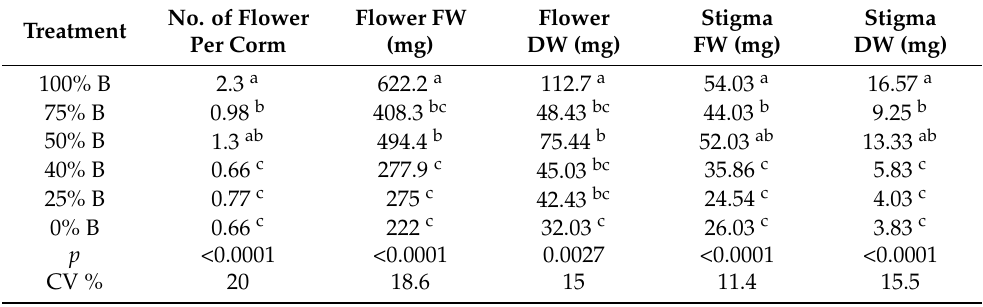
Table 2. Flower properties of saffron plants grown under different ratios of Blue (B) to Red (R) light in the overall light spectral composition, including 100% B, 75% B, 50% B, 40% B, 25% B, 0% B (see the spectrum in Figure 1), with 150 ± 10 µ mol m − 2 s − 1 PPFD. Means within a column followed by the same letters are not significantly different at p ≤ 0.01 according to Duncan’s multiple range test. CV % indicates the percentages of coefficient of variation among the